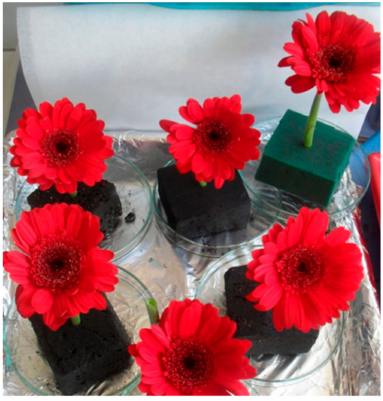
Figure 10. Appearance of cut flowers (Transvaal daisies, Gerbera spp) on a tannin–furanic foam (black) compared to a synthetic phenol–formaldehyde / furanic foam